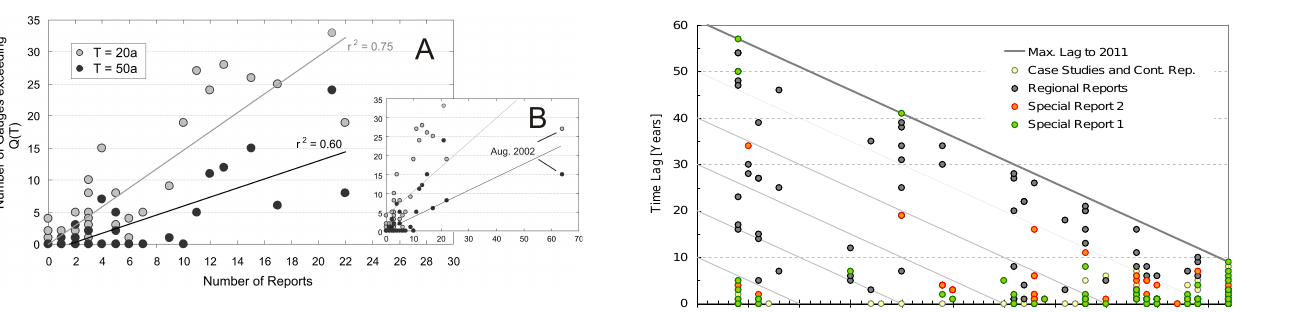
Fig. 5. Correlation of number of documents per event and event magnitude (expressed as number of gauges that exceeded the re- turn period T (20yr or 50yr) during the event). (A) Excluding the August flood of 2002; (B) including the August flood of 2002.